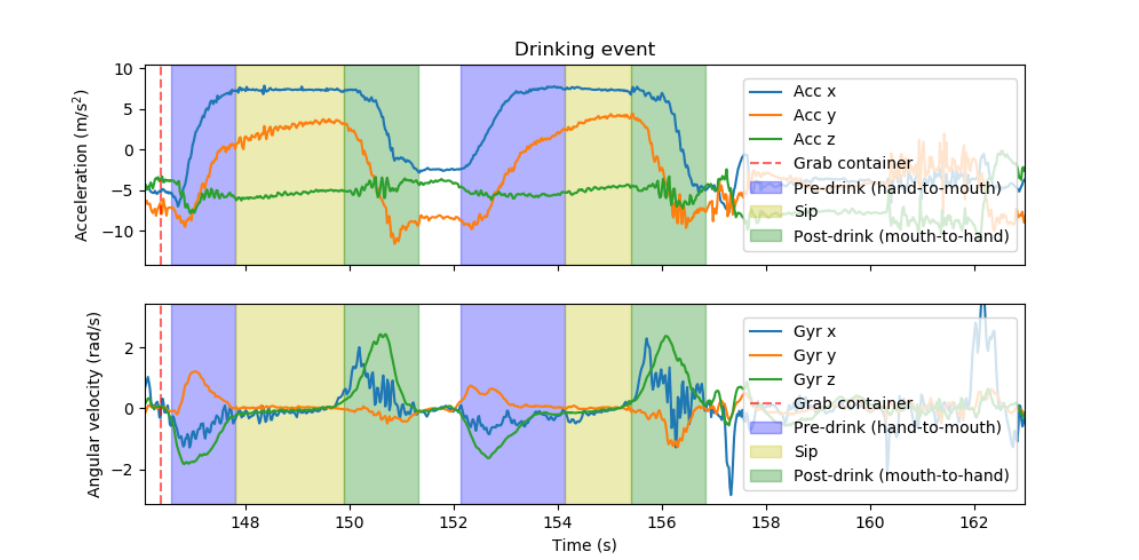
Figure 2. Annotated drinking event. Accelerometer (Acc) and gyroscope (Gyr) signals are